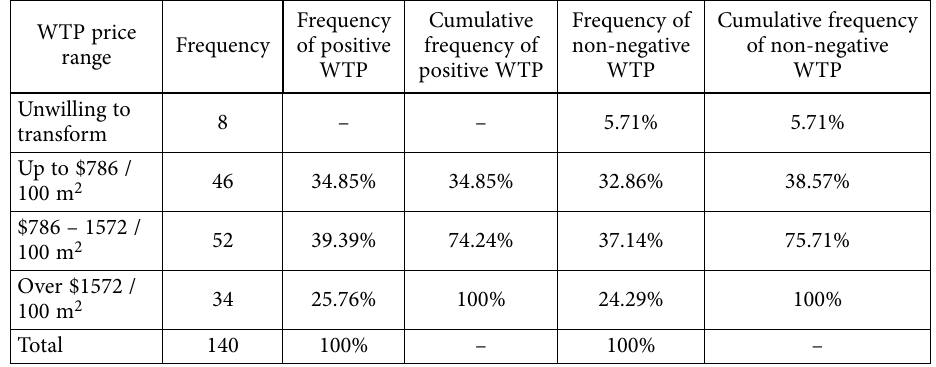
Table 4. Data sheet of residents’ WTP WTP price